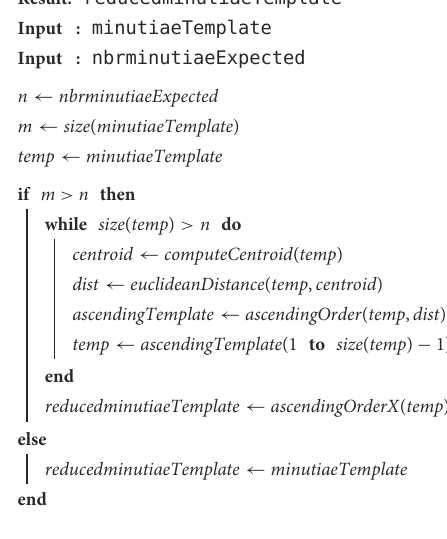
Algorithm 6. Incremental